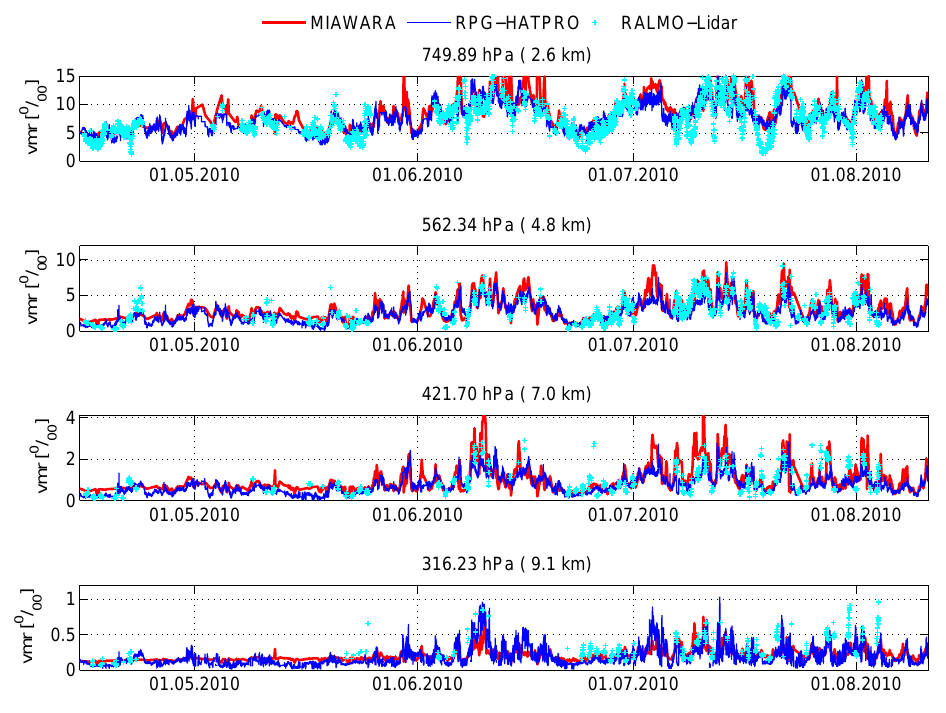
Fig. 17. Timeseries of H 2 O vmr retrieved from MIAWARA, compared with VMR retrieved from RPG-HATPRO and VMR derived from measurements of the RALMO-Lidar (both located in Payerne). All timeseries are plotted in original time resolution, RPG-HATPRO and RALMO data were regridded to MIAWARA altitude